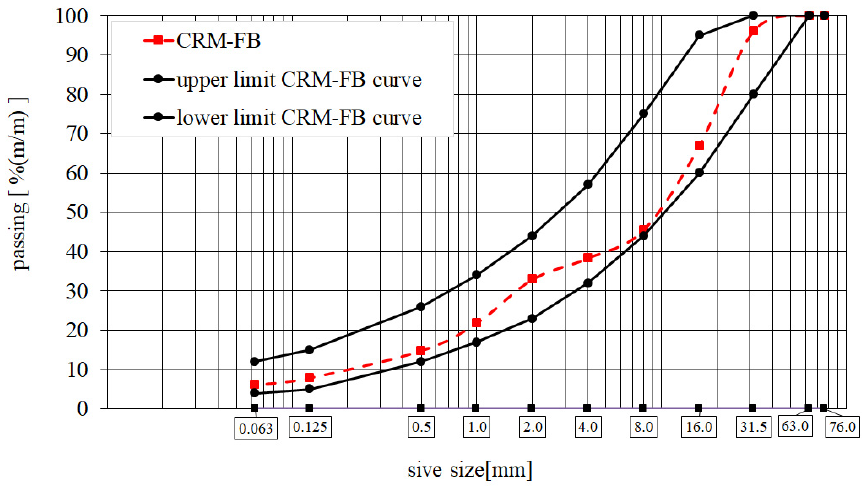
Figure 2. CRM-FB gradation curve.